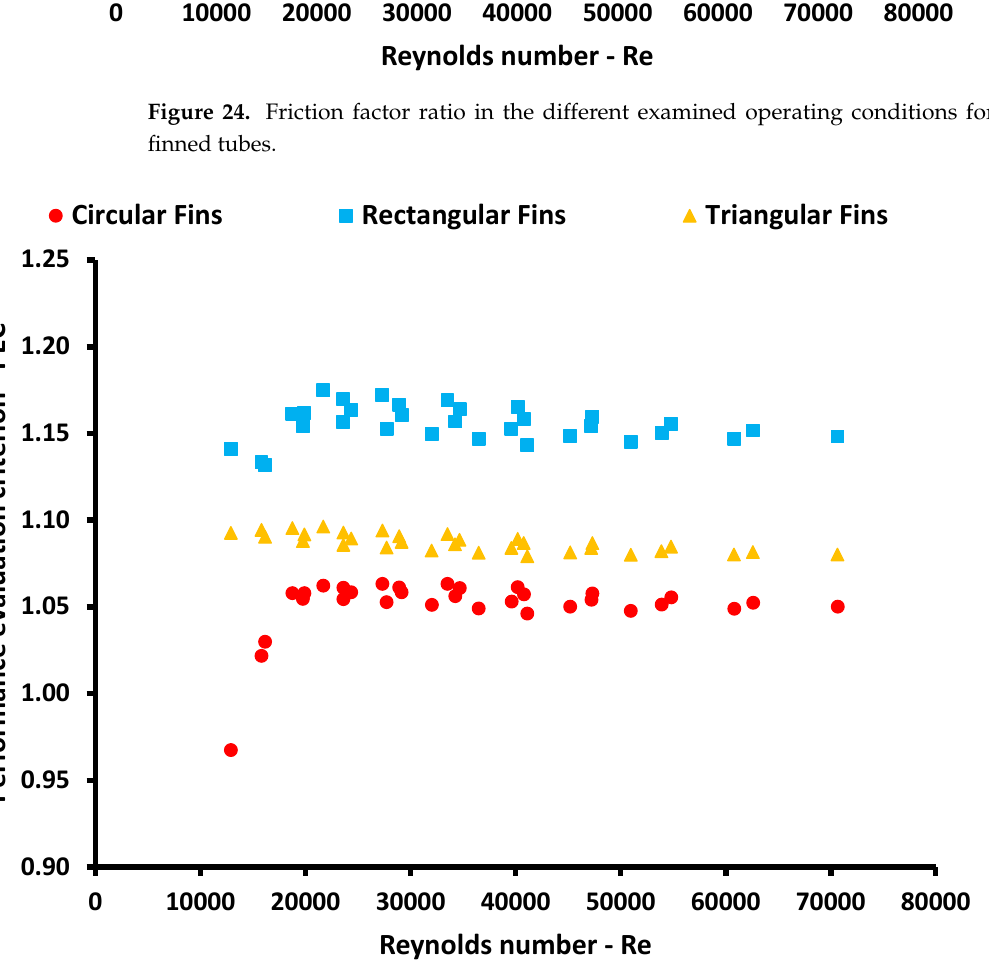
Figure 25. Performance evaluation criterion ratio in the different examined operating conditions for the different finned tubes.